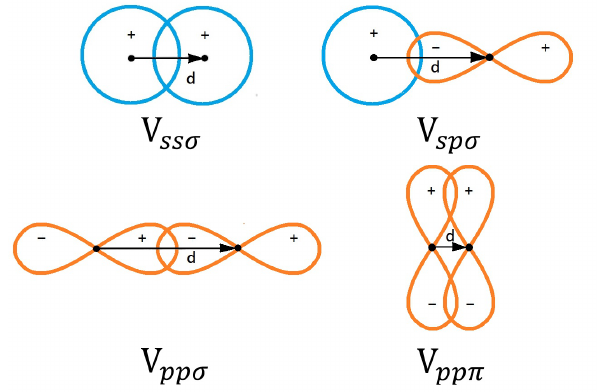
Figure 3. Illustrations for π and σ bonding of atomic s and p orbitals. Details on description of these bonding orbitals in this figure can be found in Ref.[11].